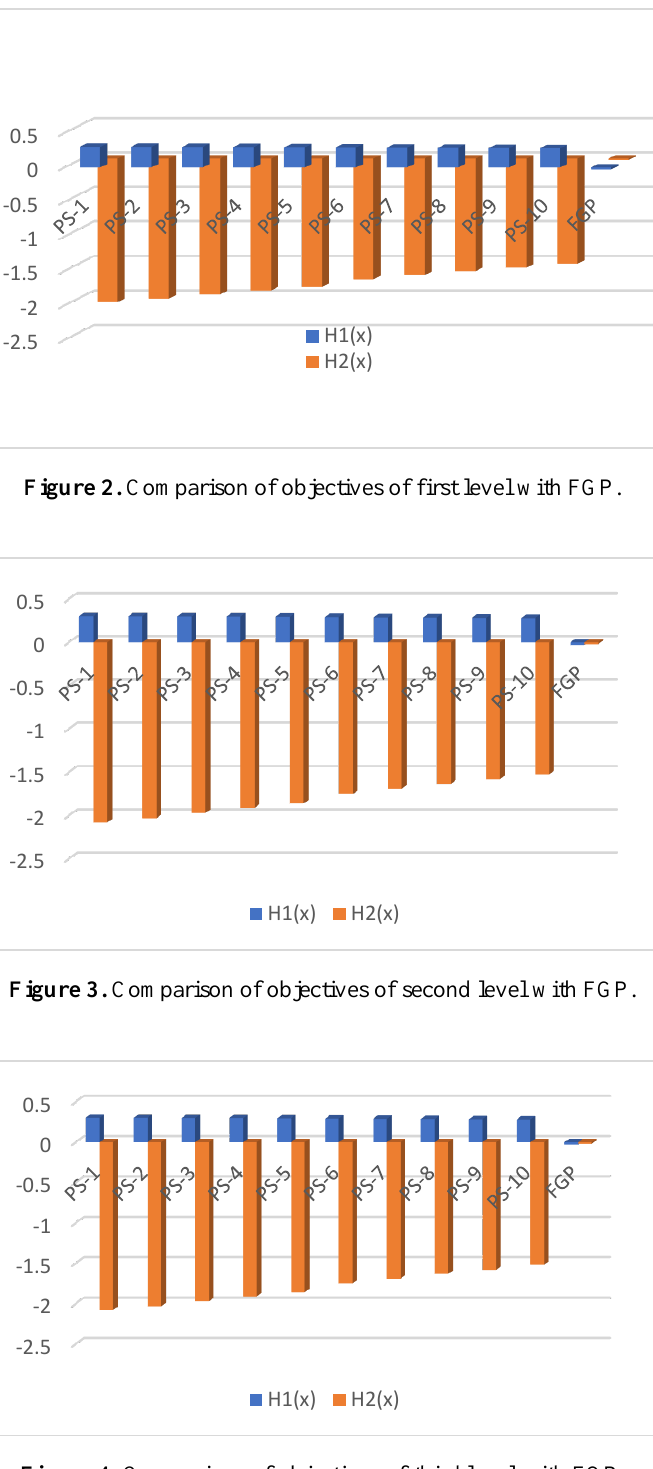
Figure 4. Comparison of objectives of third level with